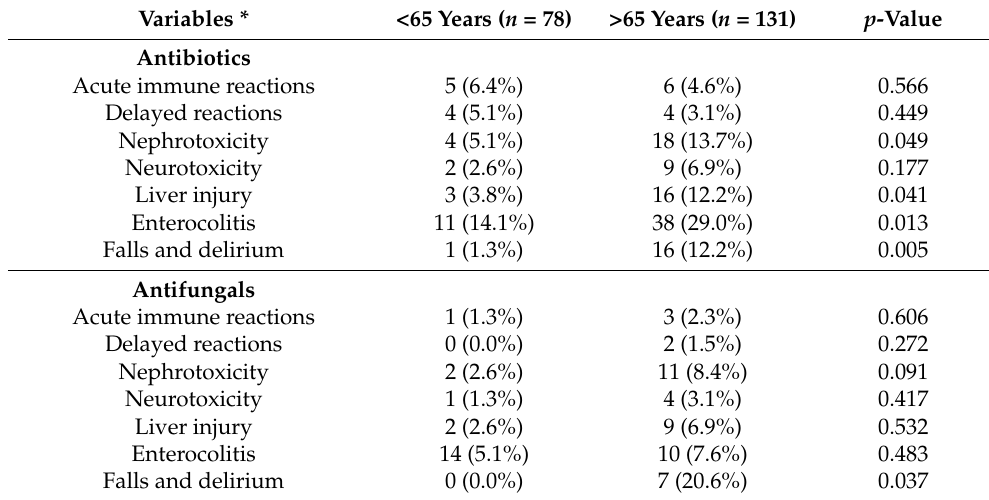
Table 5. Antibacterial and antifungal treatment side effects.